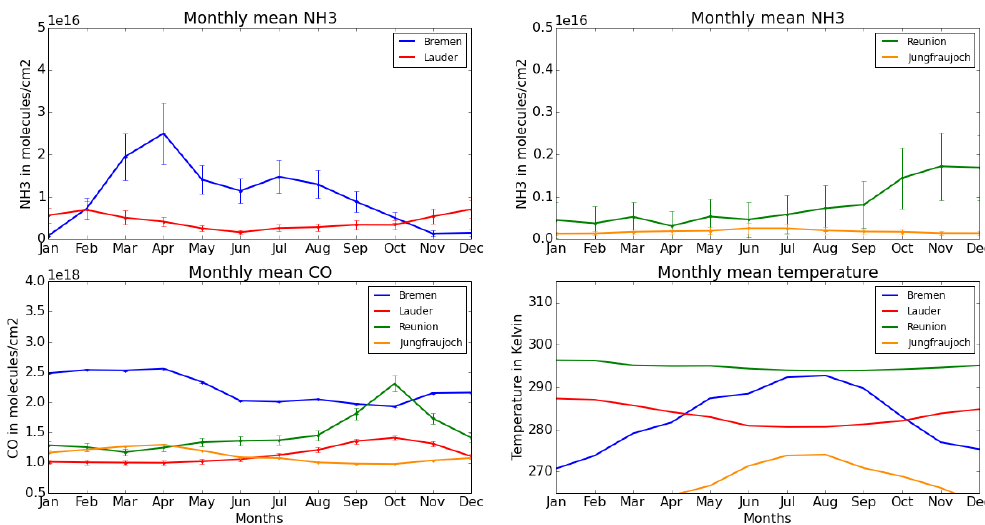
Figure 6. 2004–2013 monthly averaged columns for NH 3 , CO and temperature. The top two panels show the monthly NH 3 column concen- trations (molecules NH 3 cm − 2 ) for each of the four stations. Vertical lines indicate the mean monthly error. The bottom two panels show additional column concentrations of CO (bottom, left) and temperature (bottom,